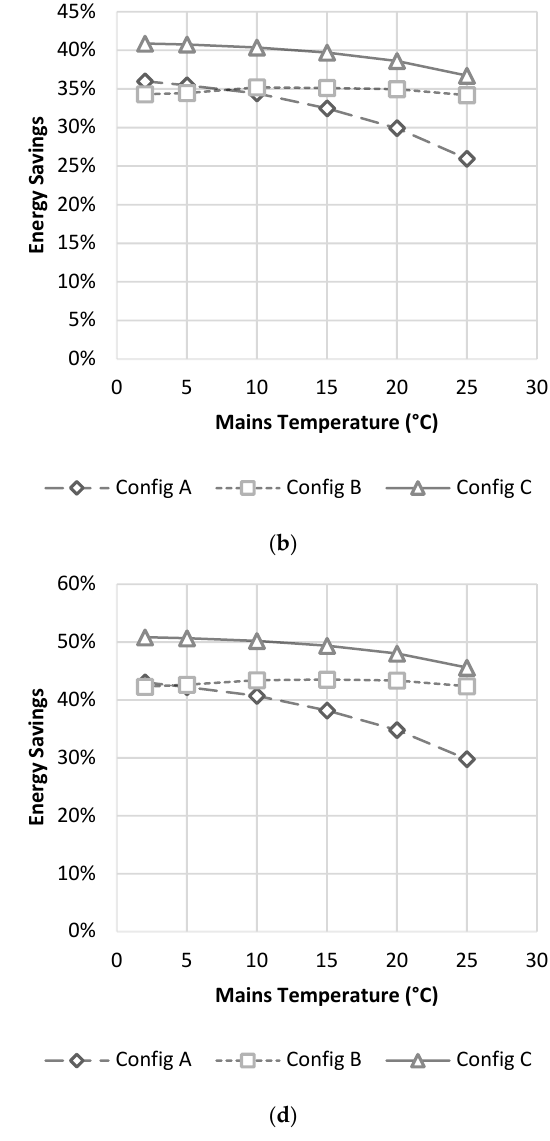
Figure 5. Energy savings as a function of mains temperature for a showerhead flowrate of 9.5 L/min for configurations A, B and C, as labelled. The plots correspond to heat exchanger 1 ( a ), heat exchanger 2 ( b ), heat exchanger 3 ( c ), and heat exchanger 4 ( d ).